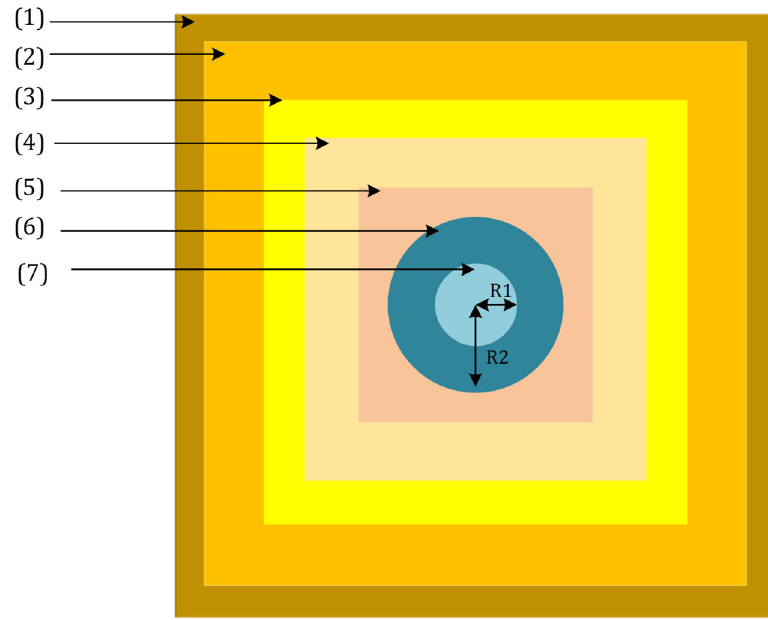
Figure 4. FDTD simulation environment for a nanoparticle. Table 1. Parameters related to FDTD simulation.